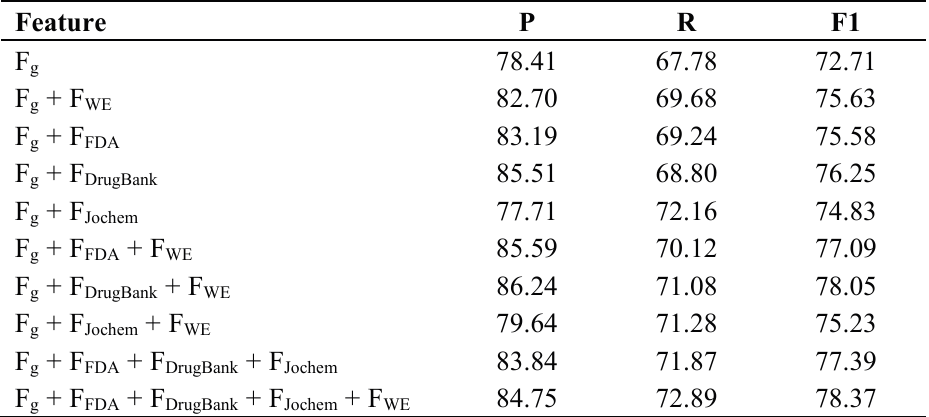
Table 2. Performances of the CRF-based DNR systems under the strict matching criterion when different features are used